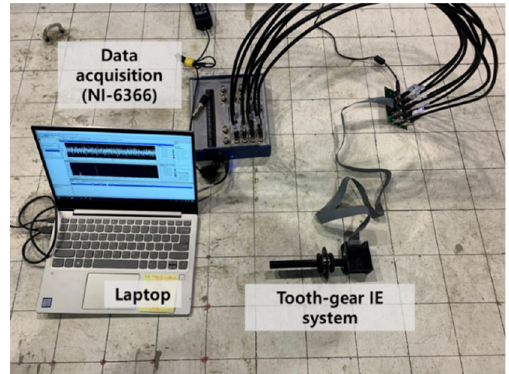
Figure 4. Designed IE system including tooth gear and microelectromechanical systems (MEMS).